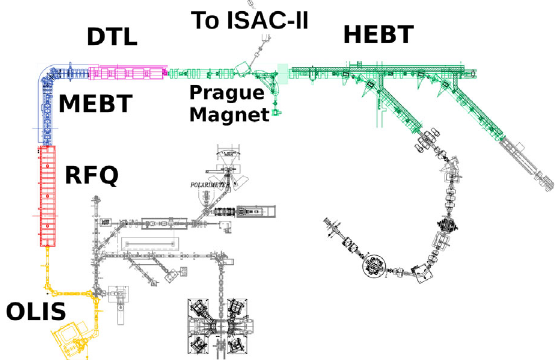
FIG. 1. Overview of the ISAC-I linear accelerator complex. The offLine ion source (OLIS) provides stable pilot beams. Beam energy is measured at the Prague (HEBT1) high energy analyz- ing magnet station, a 90° dipole which provides a reading of energy and energy